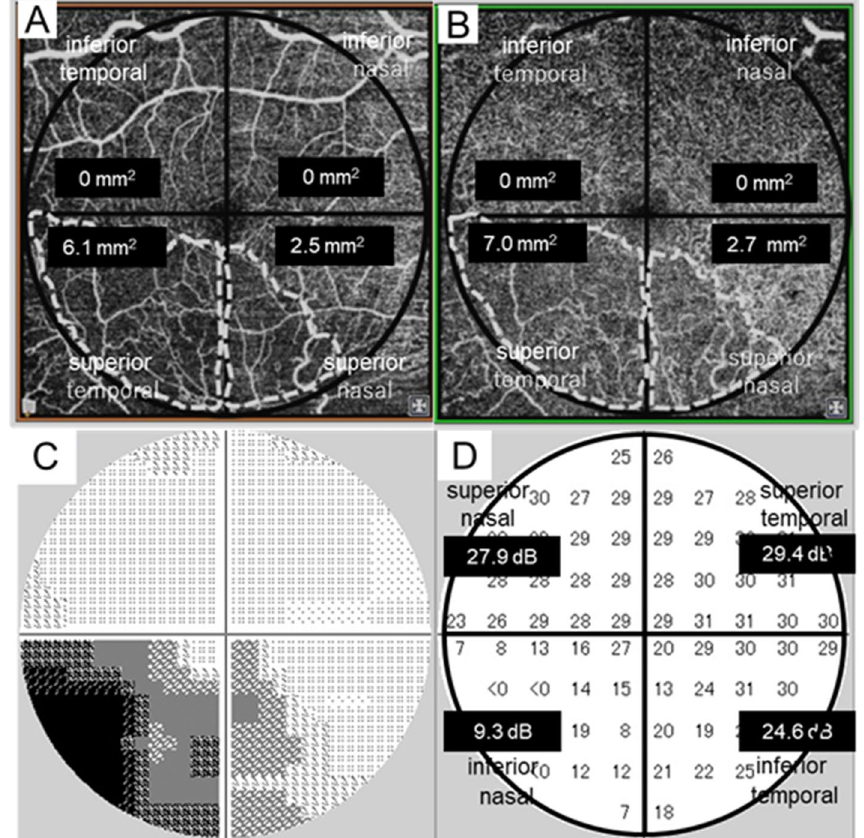
Figure 4. Upside-down images of 6 × 6 mm optical coherence tomography angiography in the superficial capillary plexus ( A ) and deep capillary plexus ( B ). The regions surrounded by the white dotted line indicate the area measured for the evaluation of the macular non-perfusion areas divided into the four-quadrant sectors (superior temporal, superior nasal, inferior temporal, inferior nasal area) in the 6-mm circle except for the foveal avascular zone. ( C ) represents the grey scale of the Humphrey visual field analyser 10-2 programme, and ( D ) represents the measured threshold. Measurement thresholds for all 68 points are organised into the four regions (17 points each: superior temporal, superior nasal, inferior temporal, inferior nasal field), and each mean visual field sensitivity is shown in ( D ). The case is the right eye (visual acuity, 20/25) of a 73-year-old female patient, 12 months following treatment with five injections of intravitreal aflibercept for supero-temporal major branch retinal vein